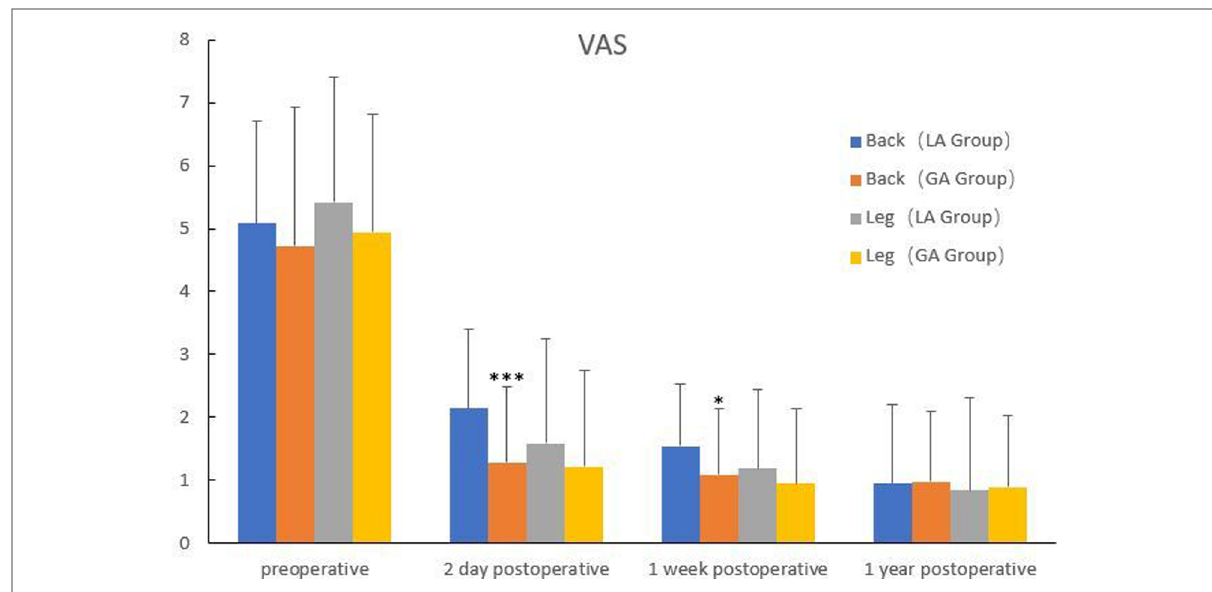
FIGURE 1 Comparison of VAS between the two groups. ***Compared with the back of LA group on the second day postoperatively, P <0.001. *Compared with the back of LA group at one week postoperatively, P <0.05.